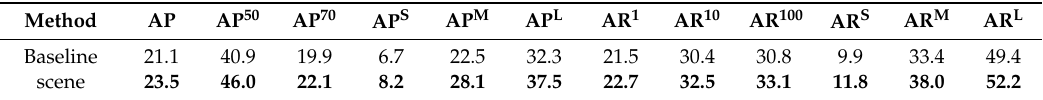
Table 6. Ablation study on MS COCO 2014 minival. All methods are trained on MS COCO train set. Baseline: Faster R-CNN trained. Scene: only using scene information. The bold characters represent the best result for each column.